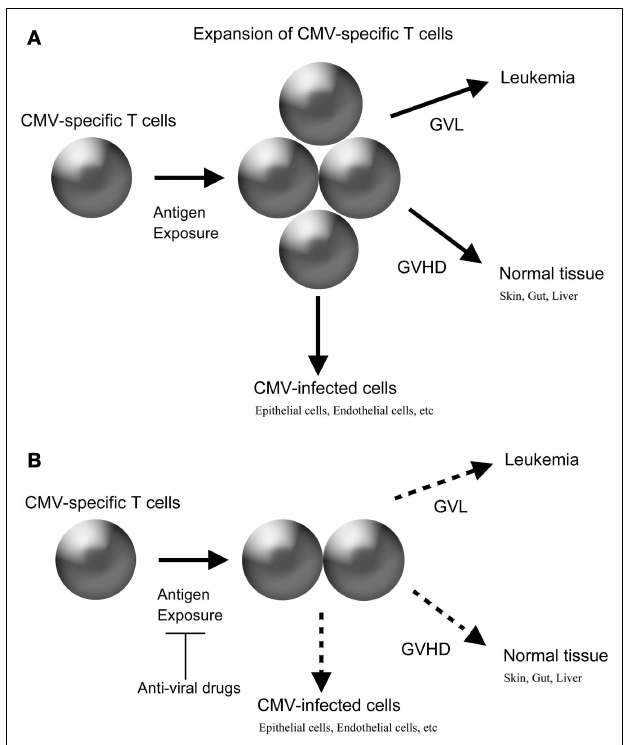
FIGURE 1 | Possible crossreactivity of CMV-specific T cells in allogeneic HSCT and the impact of anti-viral drugs . (A) Without anti-CMV drugs. (B) With anti-CMV